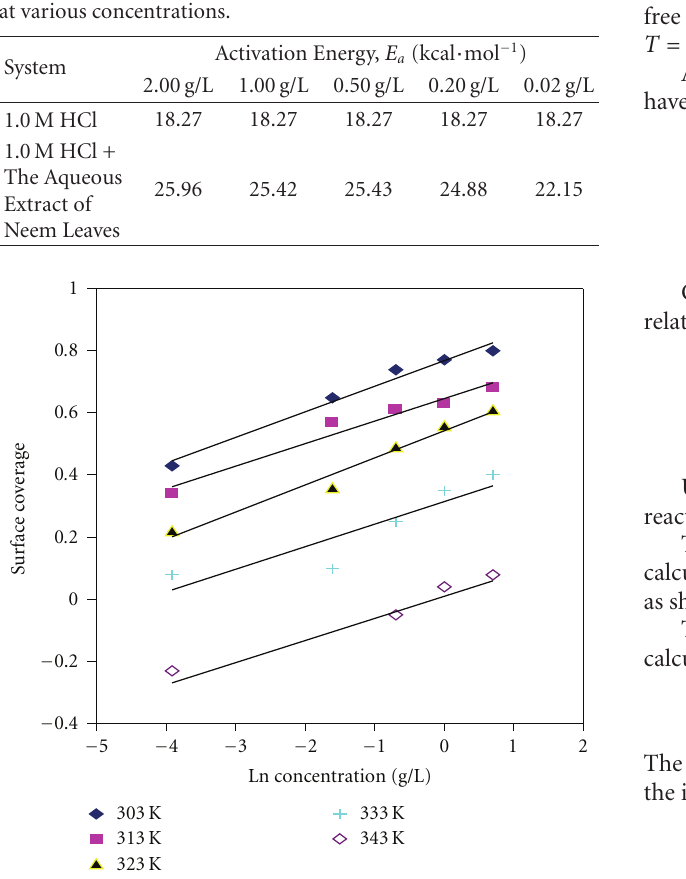
Figure 9: E ff ect of concentration of the aqueous extract of Neem leaves on the surface coverage of carbon steel in 1.0M HCl at various